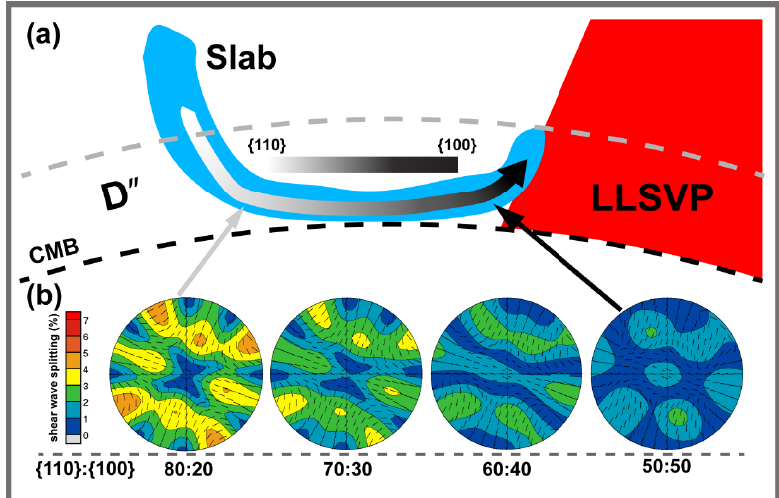
Figure 8. ( a ) Simplified scheme of a slab sheared along CMB. The greyscale gradient arrow indicates increasing {100} activity towards LLVSP. ( b ) Modeled shear wave anisotropy under 100% simple shear with different slip system activities. The CMB is horizontal and simple shear is top to the left, parallel to CMB. The black lines indicate the fast shear wave polarization direction. The anisotropy weakens towards the LLVSP due to increasing activity of the {100} system .